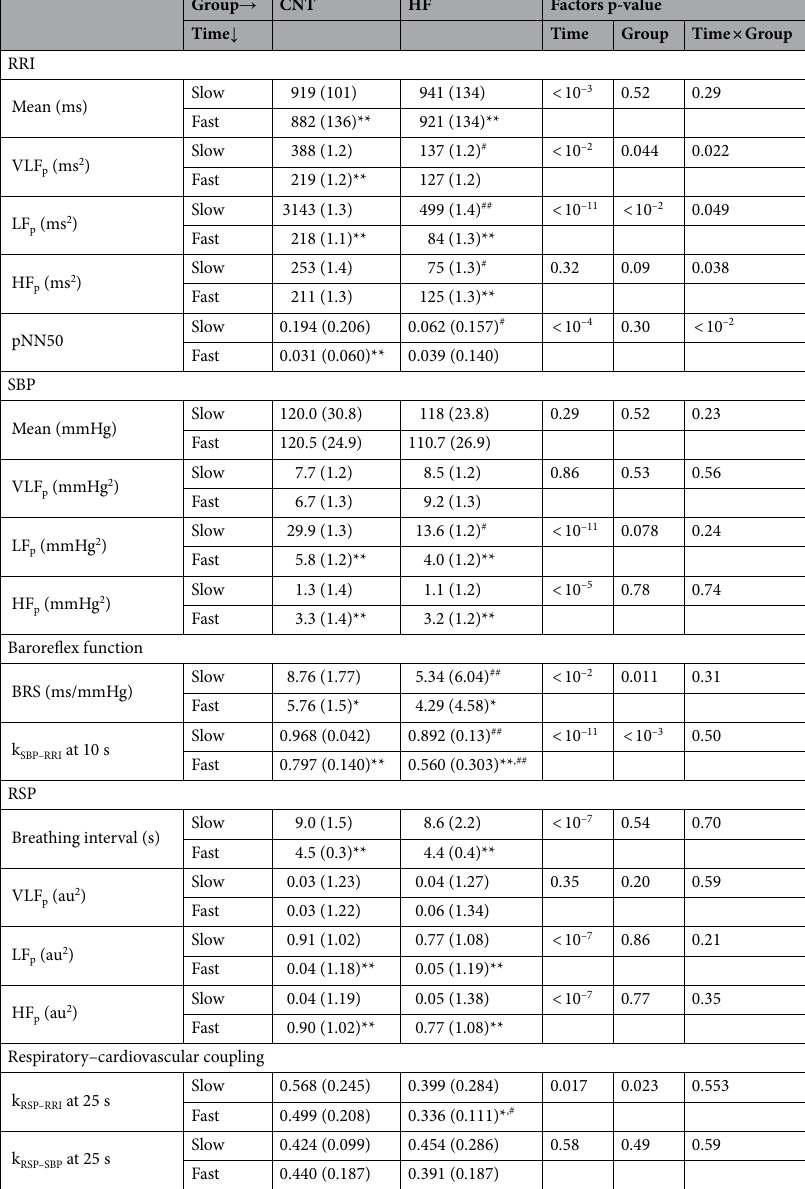
LSD: the * and ** indicate significant differences between times at p < 0.05 and < 0.01; the # and ## indicate significant differences between groups at p < 0.05 and < 0.01; RRI mean, SBP mean and breathing interval as mean (SD); powers as geometric mean (geometric SD); pNN50 and BRS as median